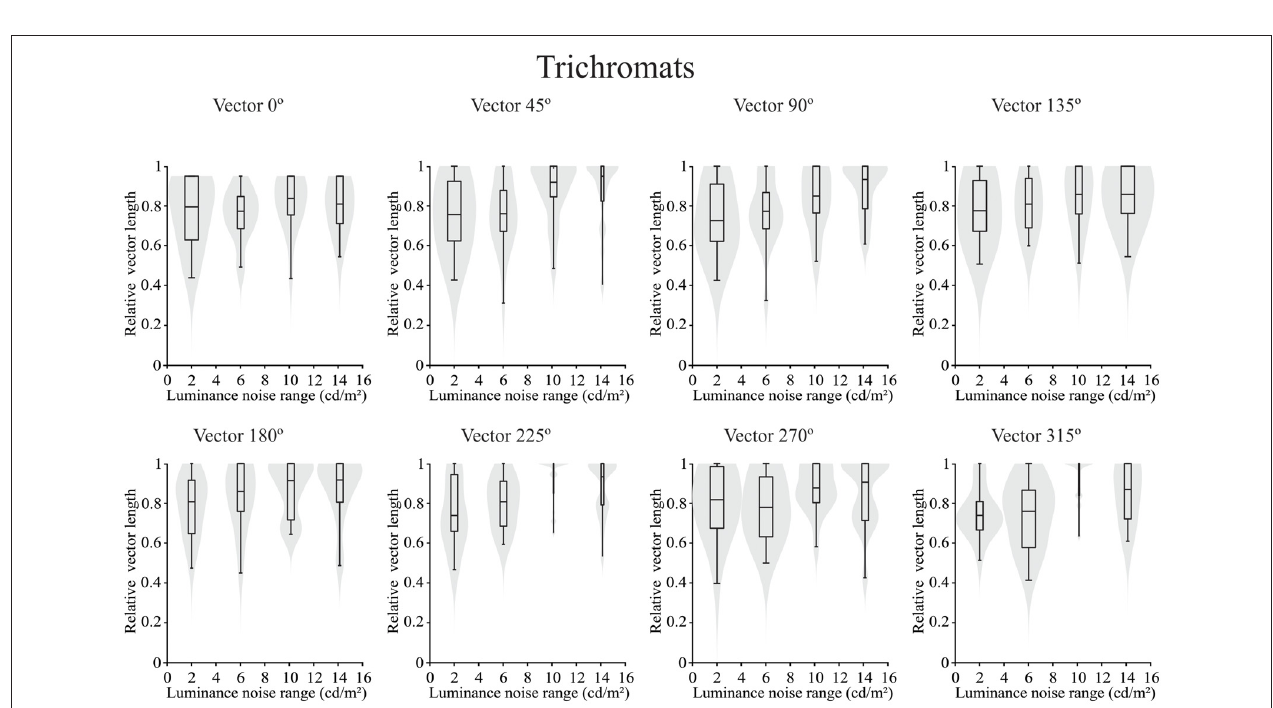
FIGURE 4 | Violin plots of relative ellipse area estimated from trichromats and congenital dichromats as a function of the luminance noise amplitude. Low luminance noise amplitude improved the color discrimination compared to high luminance noise amplitude. Shaded gray areas are the kernel density plot that represents 95% of the data distribution, and the box plot comprises horizontal lines that represent third quartile (upper line), median (middle line), first quartile (lower line) and whiskers represents the maximum and minimum values. ∗ p < 0.05.